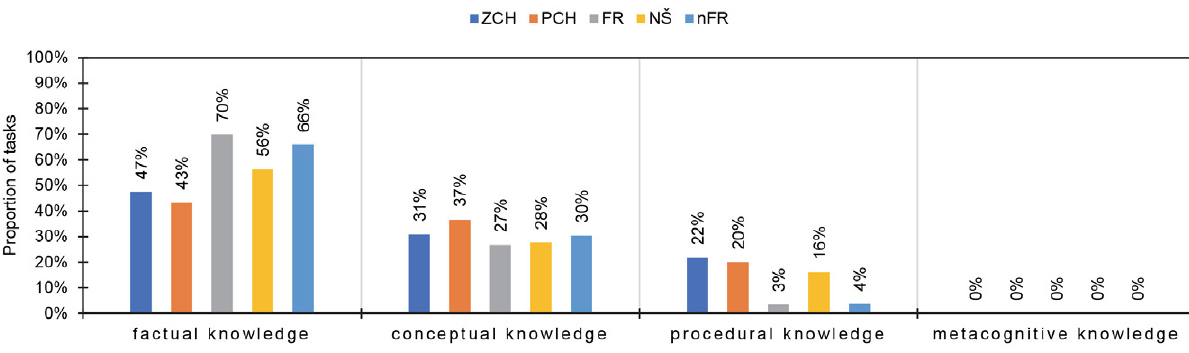
Figure 2 Proportion of textbook tasks according to required knowledge